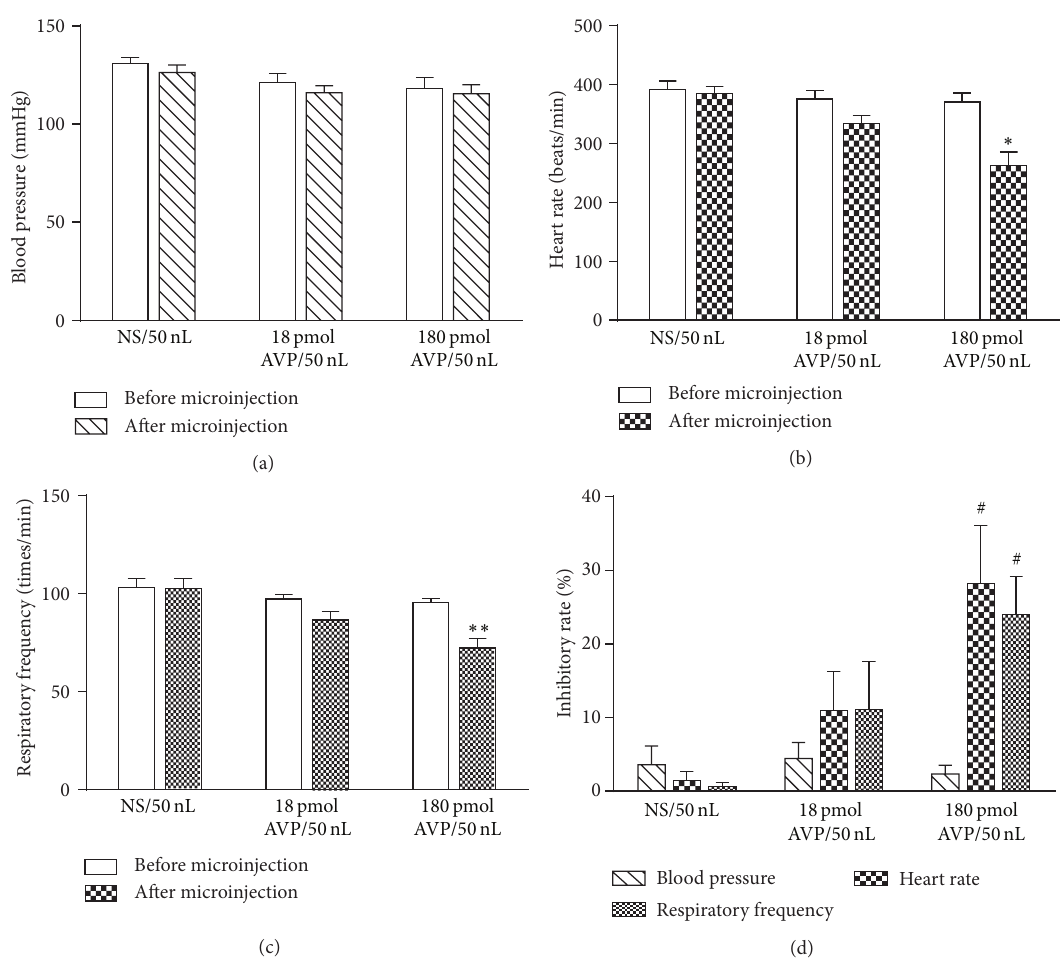
Figure 4: Effects of AVP (18 and 180 pmol) or normal saline (NS) microinjected into the DMV on blood pressure, heart rate, and respiratory frequency. Representative effects of AVP or NS on blood pressure (a) and heart rate (b) and respiratory frequency (c) before and after microinjection. The inhibitory rate of AVP or NS on blood pressure and heart rate and respiratory frequency (d). ∗ 𝑃 < 0.05 and ∗∗ 𝑃 < 0.01 , versus before microinjection; # 𝑃 < 0.05 , versus NS group in the same